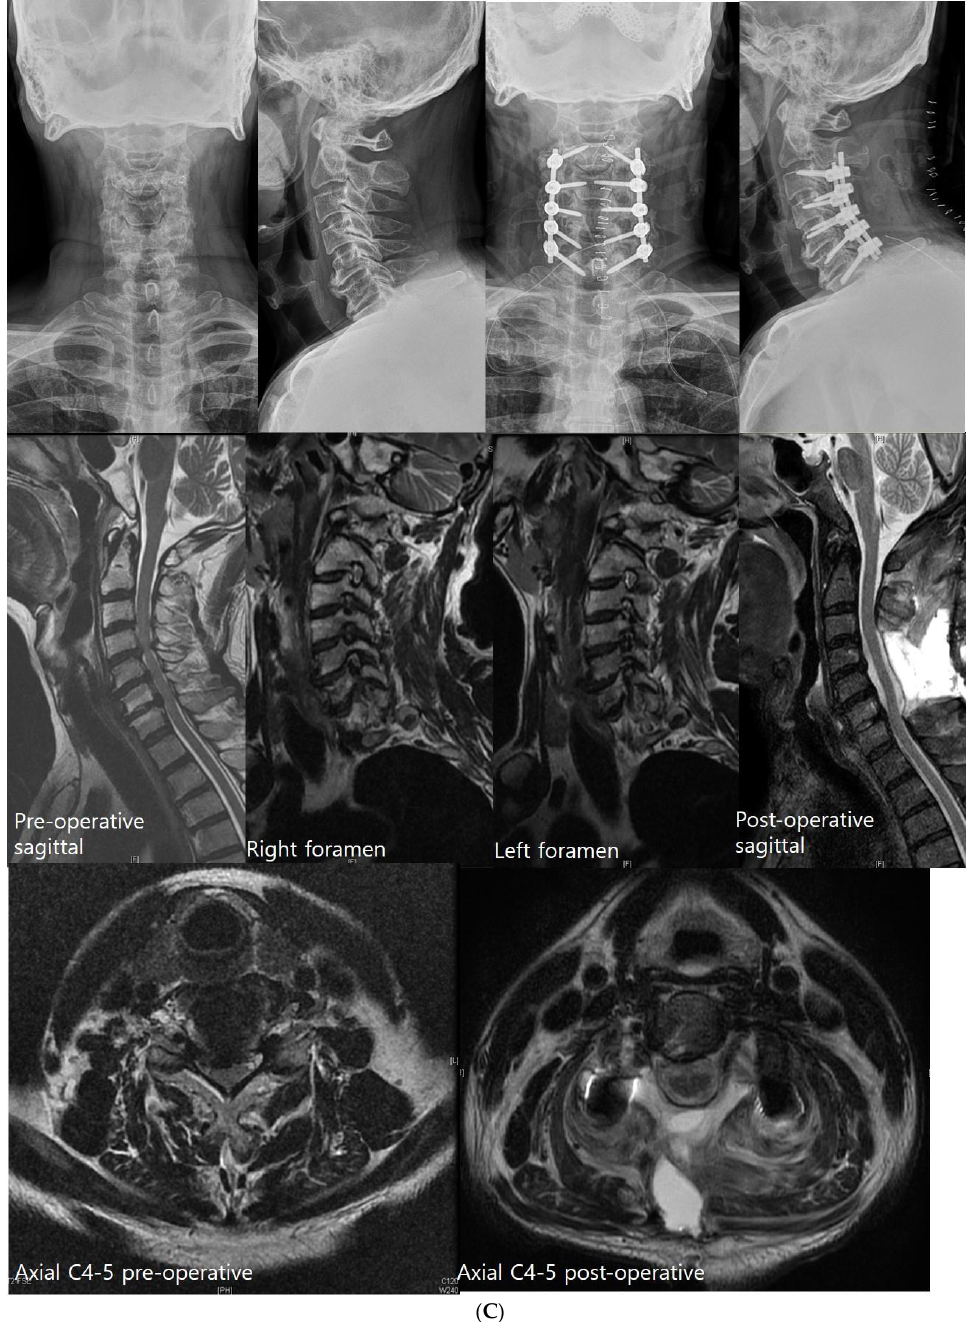
Figure 1. ( A ) Combined posterior and anterior approach with lateral mass screws (LMS) at C3 – C7 and pedicle screws at C7 (Group 1: PAP LMS with uncovertebrectomy). ( B ) Combined posterior and anterior approach with pedicle screw fixation at C3 – C7 and multiple foraminotomies (Group 2: PAP pedicle with foraminotomy). Both groups 1 and 2 demonstrated severe foraminal stenosis with decreased foraminal height, which was resolved through additional ACDF surgery. ( C ) Posterior approach with pedicle screws at C3–C7 and multiple foraminotomies (Group 3: posterior pedicle with foraminotomy). Compared with groups 1 and 2, group 3 demonstrated relatively well-preserved foraminal height, although with foraminal stenosis, which could be decompressed successfully by posterior foraminotomy